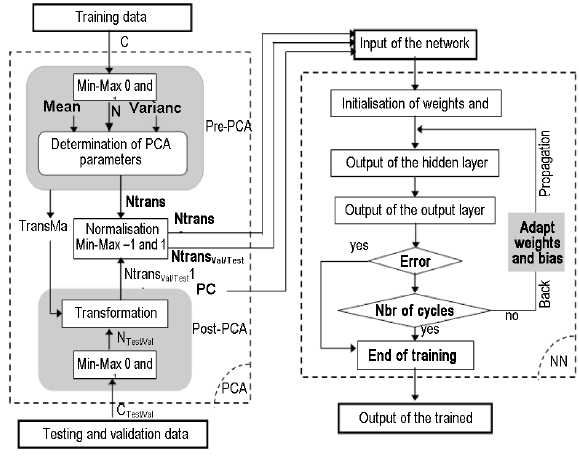
Fig. 7. Methodology of implementation of PCA and